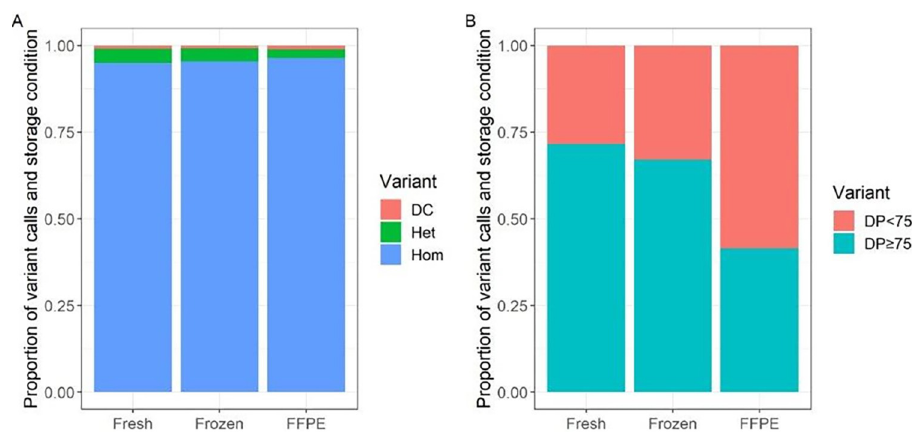
Fig 5. Concordance between DNA and RNA variants among different storage conditions. (A) Proportion of concordant (Het = heterozygous, Hom = homozygous) and discordant (DC) variant calls in loci with read depth (DP) � 75. (B) Proportion of detected variants with read depths too low (DP < 75) for reliable variant calls. Abbreviations: FFPE = Formalin-fixed, paraffin-embedded.